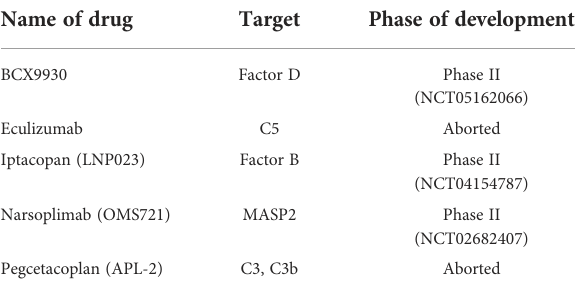
TABLE 1 Complement-based therapies currently under trial for MN. Name of